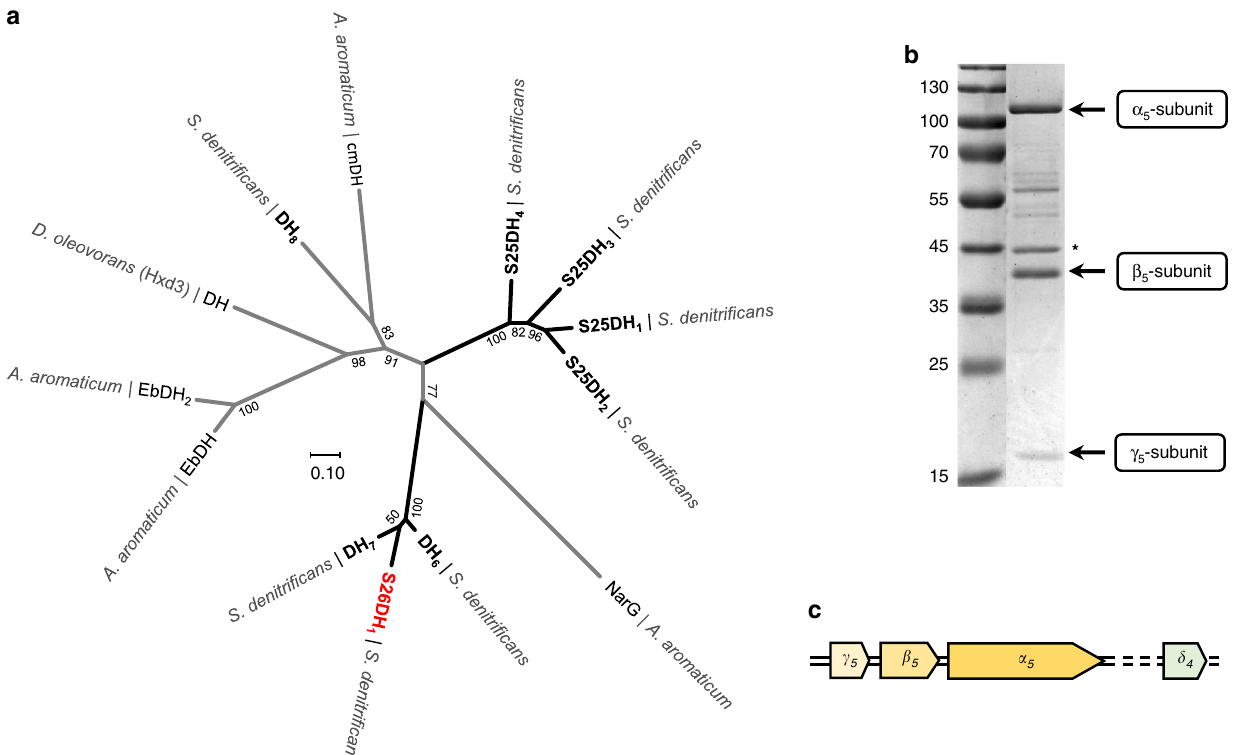
Fig. 4 Phylogeny and enrichment of recombinant S26DH 1 from S. denitri fi cans . a Phylogenetic tree of S25DH-like Mo-enzymes of the DMSO reductase family. A . = Aromatoleum ; D . = Desulfococcus ; α -subunits of CmDH = p -cymene dehydrogenase; EbDH = ethylbenzene dehydrogenase; NarG = nitrate reductase. The previously assigned DH 5 is now referred to as S26DH 1 (marked in red). b SDS – PAGE of S26DH 1 heterologously produced in T. aromatica ; the numbers refer to the molecular masses (kDa) of a standard. The band marked with an asterisk was identi fi ed as co-puri fi ed 6-oxocyclohex-1-ene-1- carboxyl-CoA hydrolase from T. aromatica ; the minor band eluting slightly above the 55 kDa is a degradation product of the α 5 -subunit (Supplementary Table 2). c Cluster of genes encoding the αβγ -subunits and the gene encoding the δ -chaperone of S26DH 1 (accession numbers: γβα